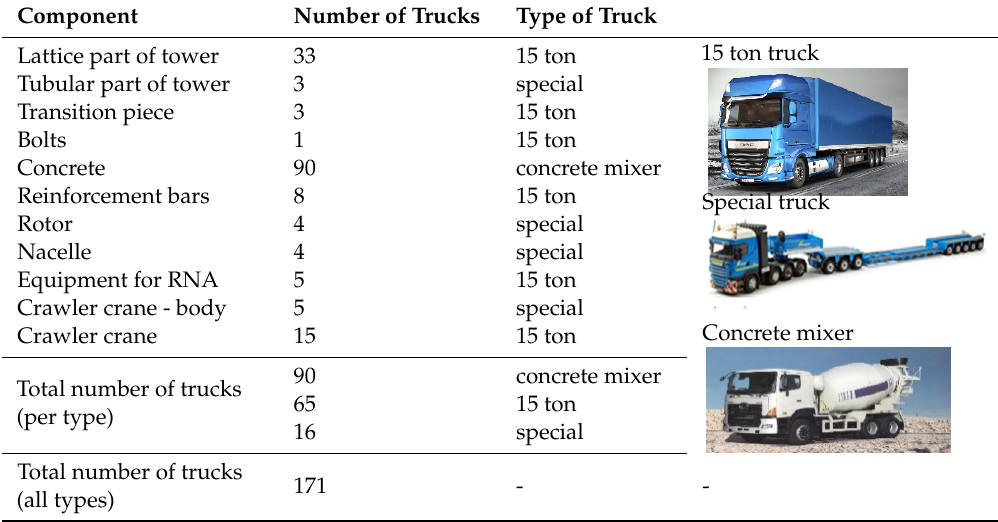
Table 4. Description of the erection process—time estimation.